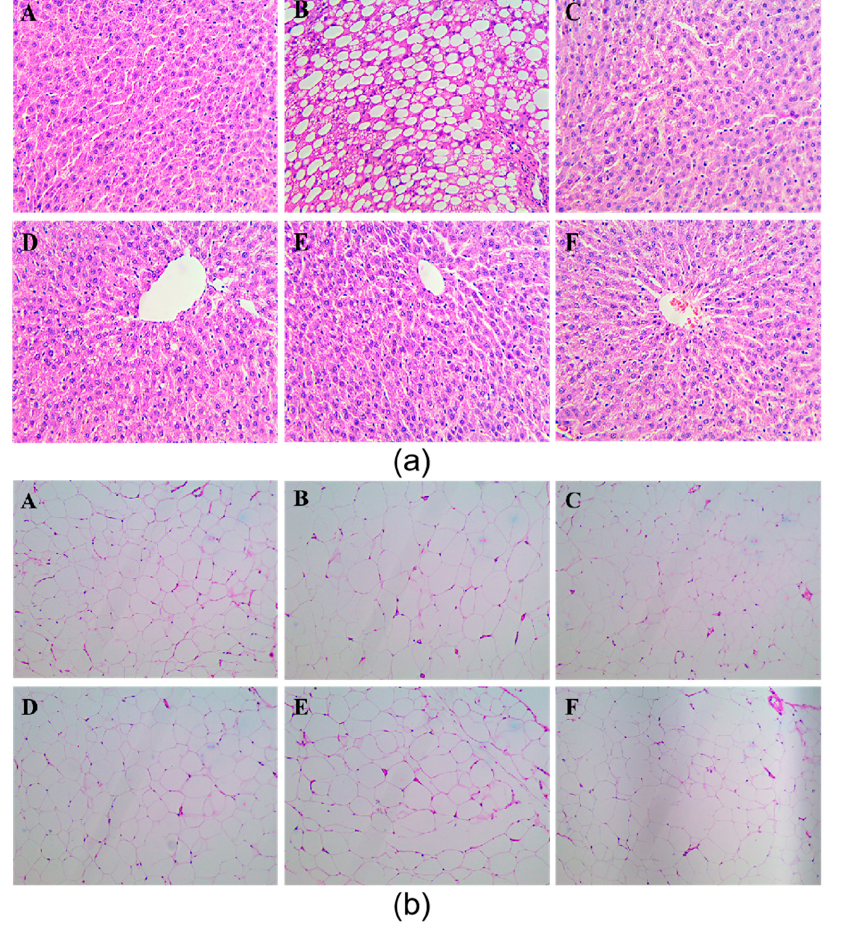
Figure 2. Pathological observation of liver ( a ) and peri-testicular fat ( b ). ( A ): the normal